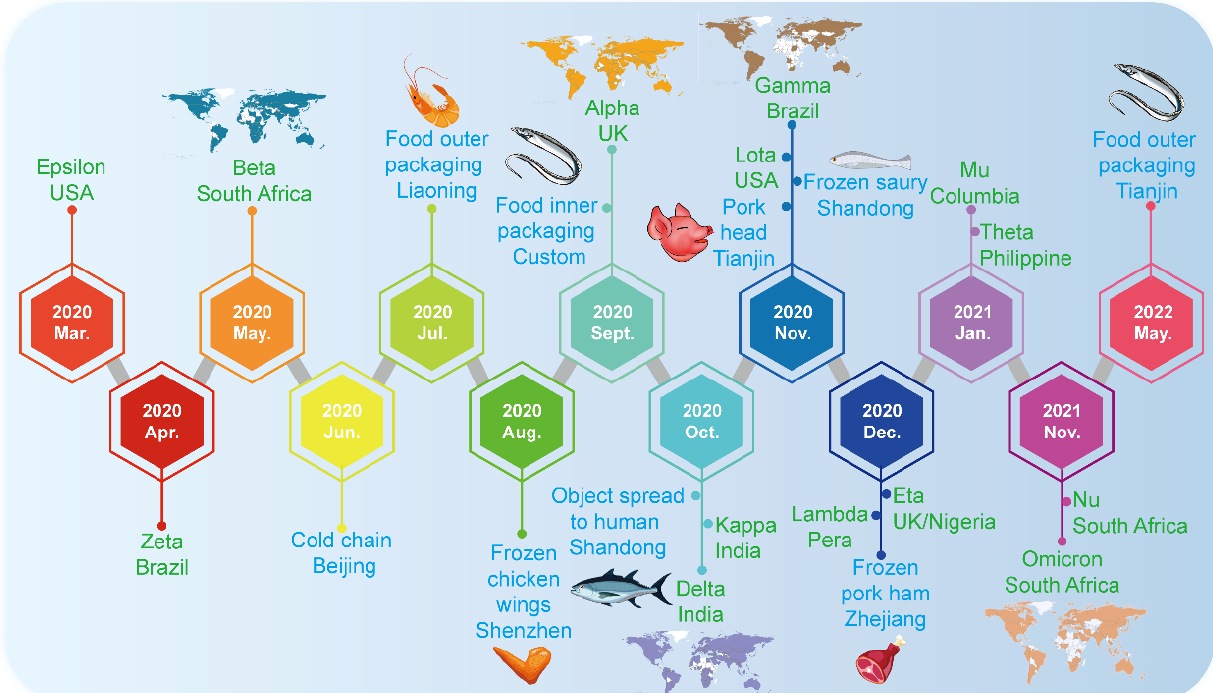
Figure 2. Timeline of the emergence of SARS-CoV-2 variants and SARS-CoV-2-related cold-chain food incidents. The blue font indicates the time point when novel coronavirus was detected in cold-chain foods in China. The green font indicates the timeline of the emergence of SARS-CoV-2 variants and those of greater concern. The worldwide spread of five variants of concern (VOCs) is also shown.